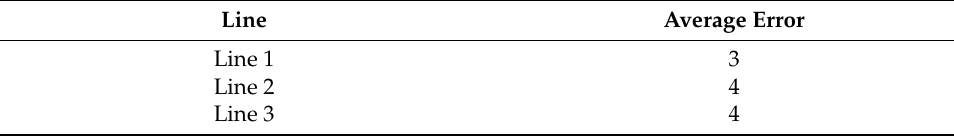
Table 2. The average error of pixel on vertices of each line by using diamonds.